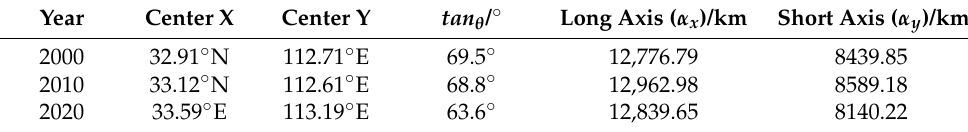
Table 3. Variation in parameters of the SDE of RPA in China from 2000 to